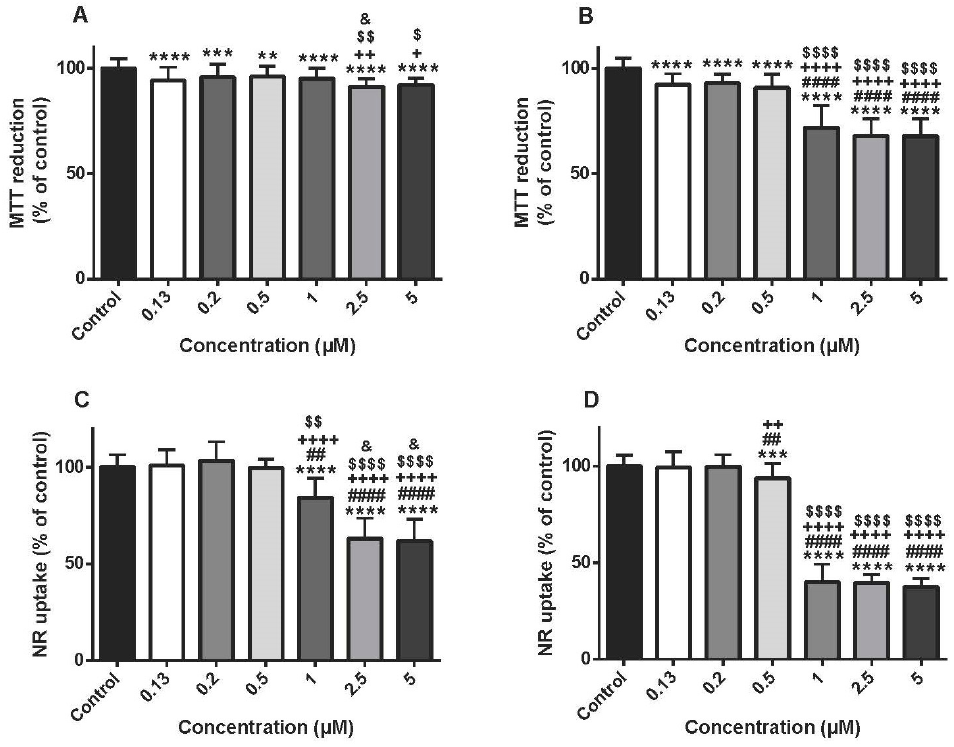
Figure 1. Mitochondrial and lysosomal dysfunction evaluated by the 3-(4,5-dimethylthiazol-2-yl)-2,5-diphenyl tetrazolium bromide (MTT) reduction assay ( A , B ) and the neutral red (NR) uptake assay ( C , D ), respectively, in differentiated H9c2 cells incubated with 0.13, 0.2, 0.5, 1, 2.5 and 5 μ M of doxorubicin (DOX) for 24 ( A , C ) and 48 h ( B , D ). Results are presented as mean ± SD of 6–7 independent experiments (total of 30–42 wells). Statistical analyses were performed using the ANOVA test, followed by the Tukey’s post hoc test ( A , B , D ) and the Kruskal–Wallis test, followed by the Dunn’s post hoc test ( C ) (** p < 0.01, *** p < 0.001, **** p < 0.0001 vs. control; ## p <